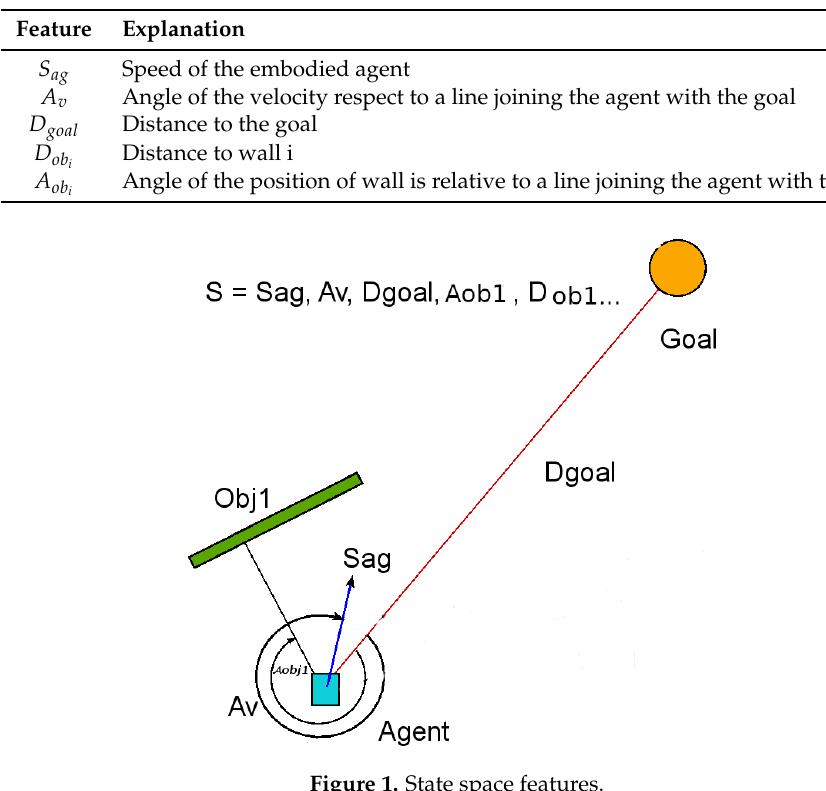
Table 1. State space features.